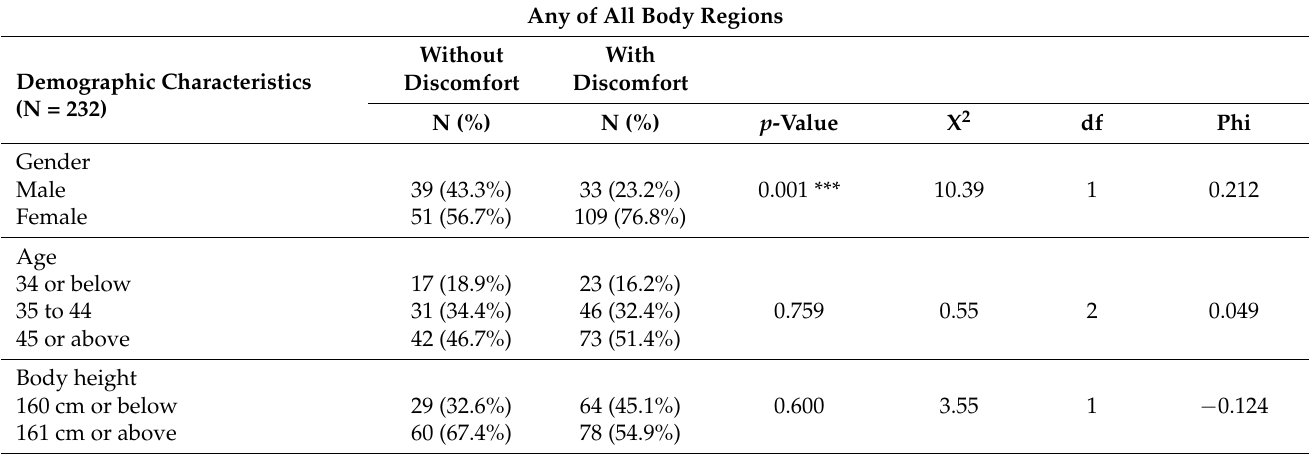
Table A2. The association between demographic characteristics and with/without musculoskeletal discomfort of any of all body